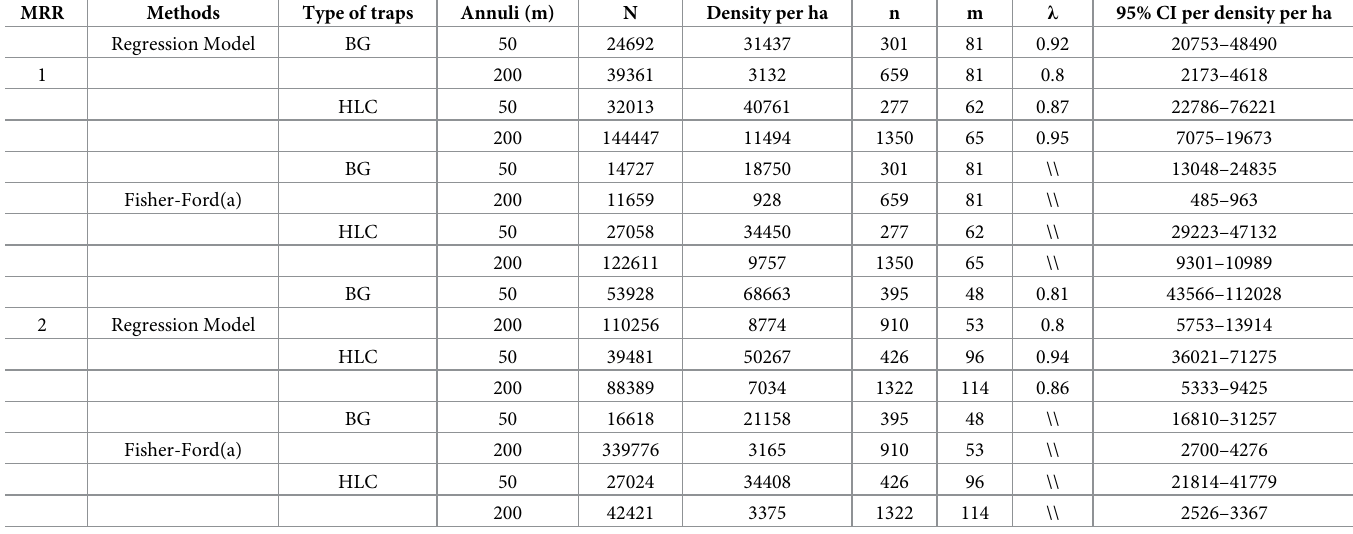
Table 5. Wild Aedes albopictus population size on Procida Island and survival of sterile males estimated based on mark-release-recapture (MRR) experiments within either a 50m- and a 200m-areas around release site. Density/ha = number of males/ha; N = estimate of population size/day; λ = survival rate estimated by